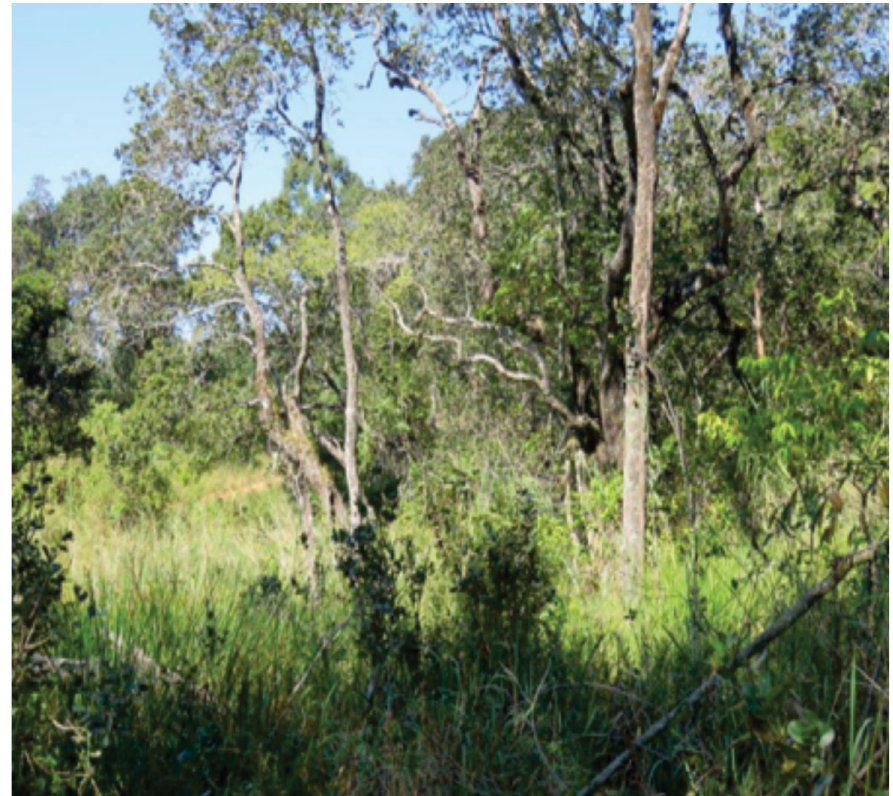
Fig. 6 . Swamp forest habitat where P. mariepskoppie sp. nov., was collected at the Blyde Canyon Nature Reserve, below the Mariepskop Mountains, Mpumalanga Province, South